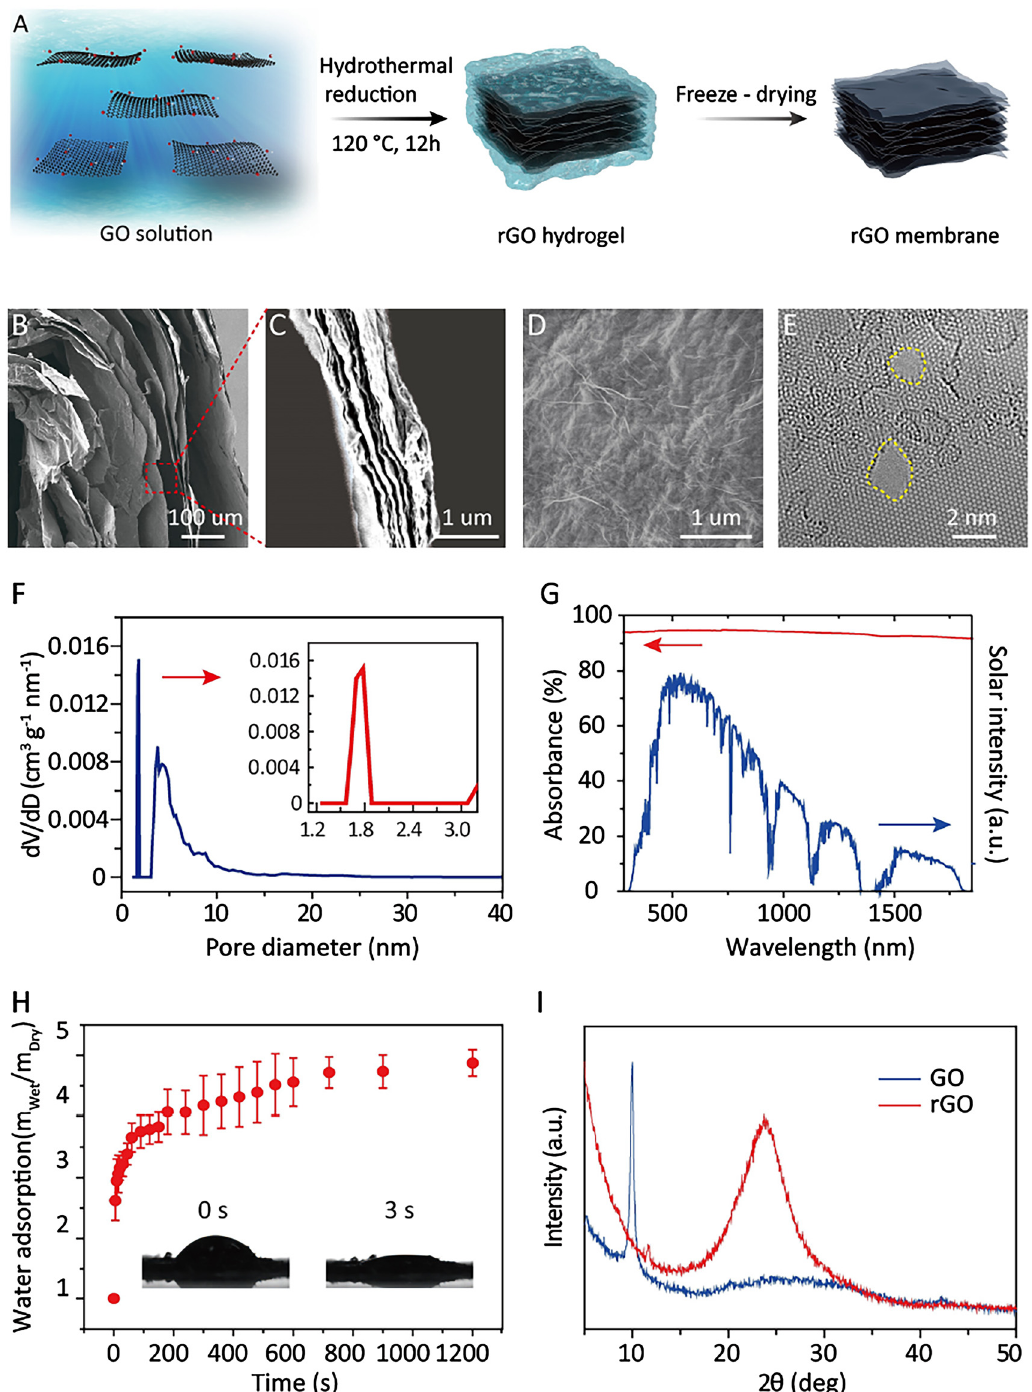
Figure 2: The fabrication process and characterizations of the reduced graphene oxide (rGO) membrane. (A) Schematic of the fabrication process for the free-standing rGO membrane. Cross-sectional scanning electron microscopy (SEM) images of the rGO membrane at low and high (B and C) resolution. It shows that each slice consists of numerous layered laminates that are stacked together.(D)SEMimageofthesurfacemorphologyfortherGOmembrane.(E)Transmissionelectronmicroscopy(TEM)imageofnanoporesas the defects on the rGO sheets. (F) Pore size distribution of the rGO membrane calculated by carbon dioxide adsorption data. (G) Solar absorption of the rGO membrane together with the solar intensity. (H) Water adsorption ratio of the membrane. The insets are the water contact angles of the membranemeasuredat 0 s (the first momentof the water droplet touching the membranesurface)andafter 3 s. (I) X-ray diffraction (XRD) spectra of GO and rGO membrane. GO, graphene